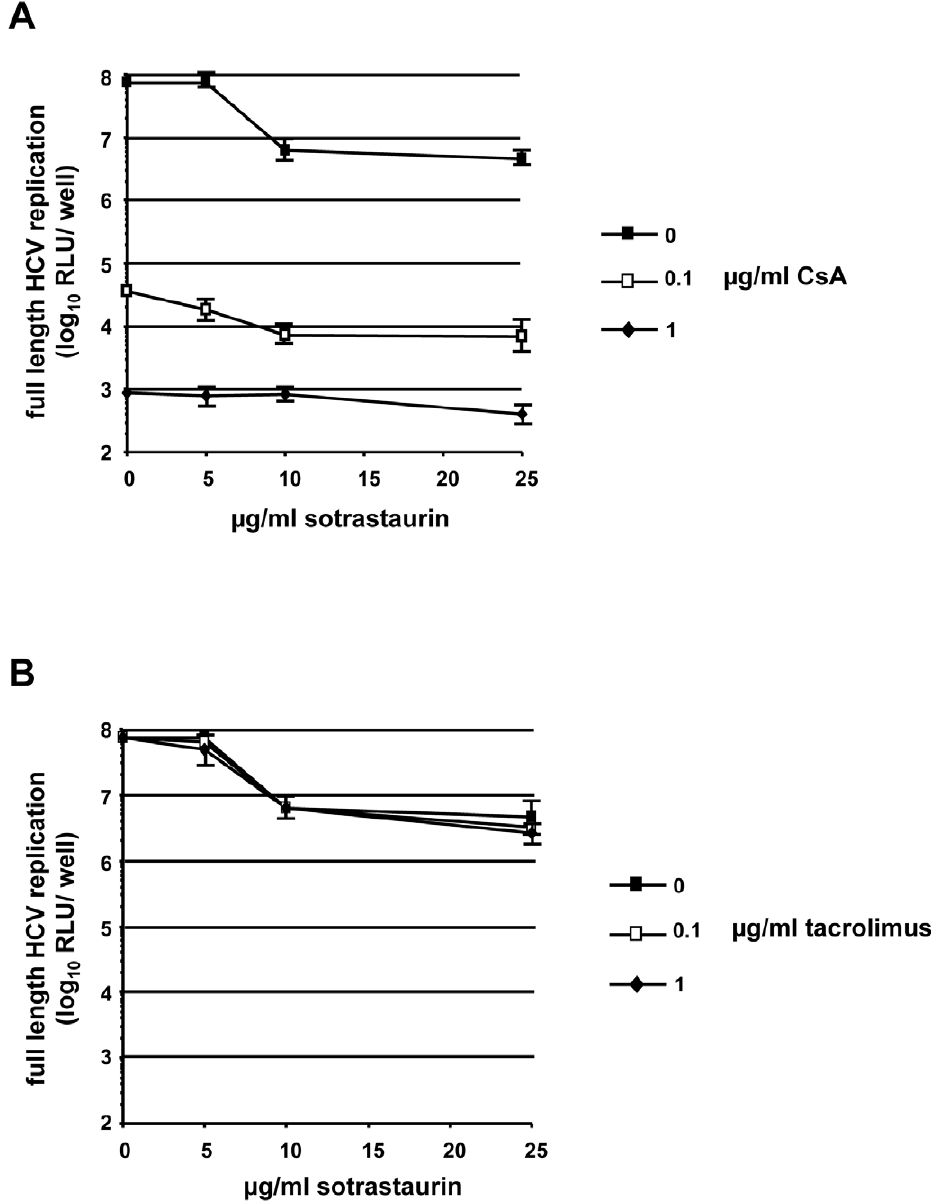
Figure 4: Combination of sotrastaurin with calcineurin inhibitors. (A, B) Effect of different concentrations of sotrastaurin plus (A) CsA or (B) tacrolimus on HCV Jc1-Luc replication at 48 h after electroporation. doi:10.1371/journal.pone.0024142.g004 PLoS ONE |